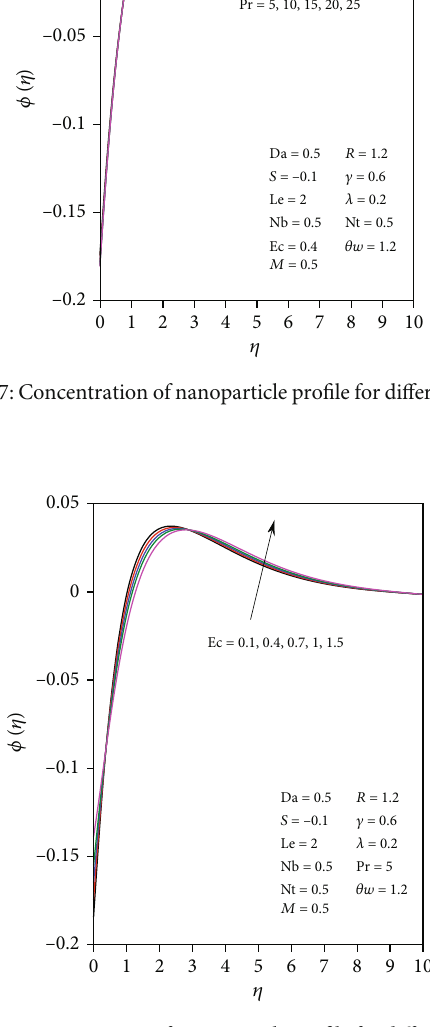
Figure 18: Concentration of nanoparticle pro fi le for di ff erent values of Ec